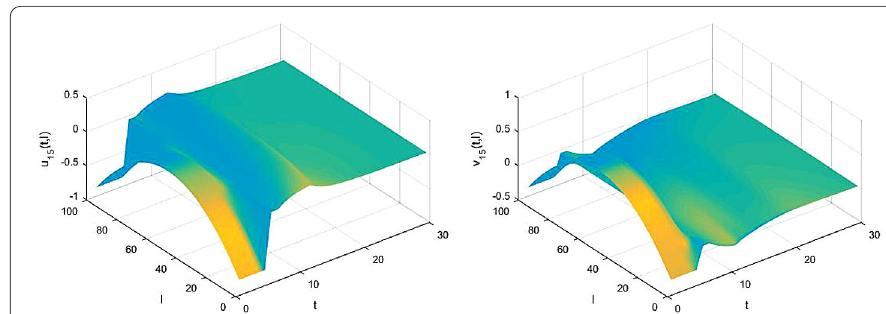
Figure 5 The trajectory of u 15 ( t , l ) and v 15 ( t , l ).